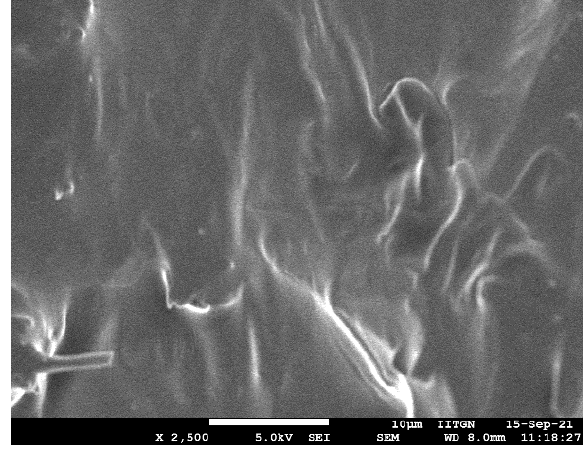
Figure 10. Representative scanning electron microscopy image of optimized formulation (F8).